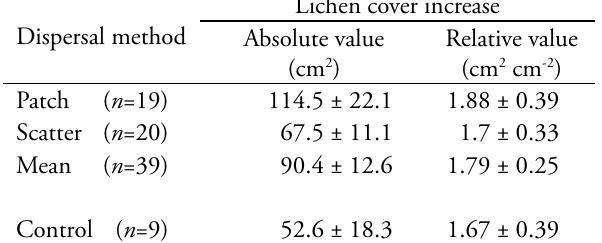
Table 1. Increases in lichen cover (mean ± SEM) between 2006 and 2008 in patch dispersal, scatter dispersal and control